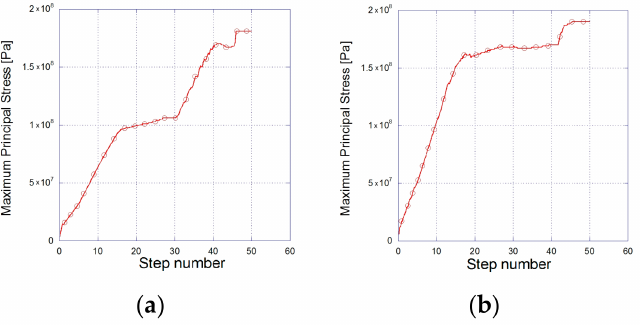
Figure 6. Maximum principal stress during the transient thermomechanical analysis for ( a ) the circular and ( b ) the oval microparticle.